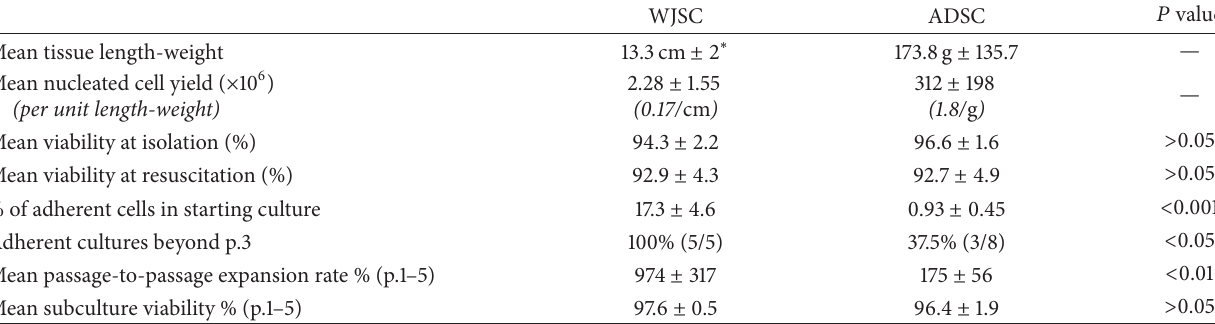
Table 1: Cell isolation and culture establishment